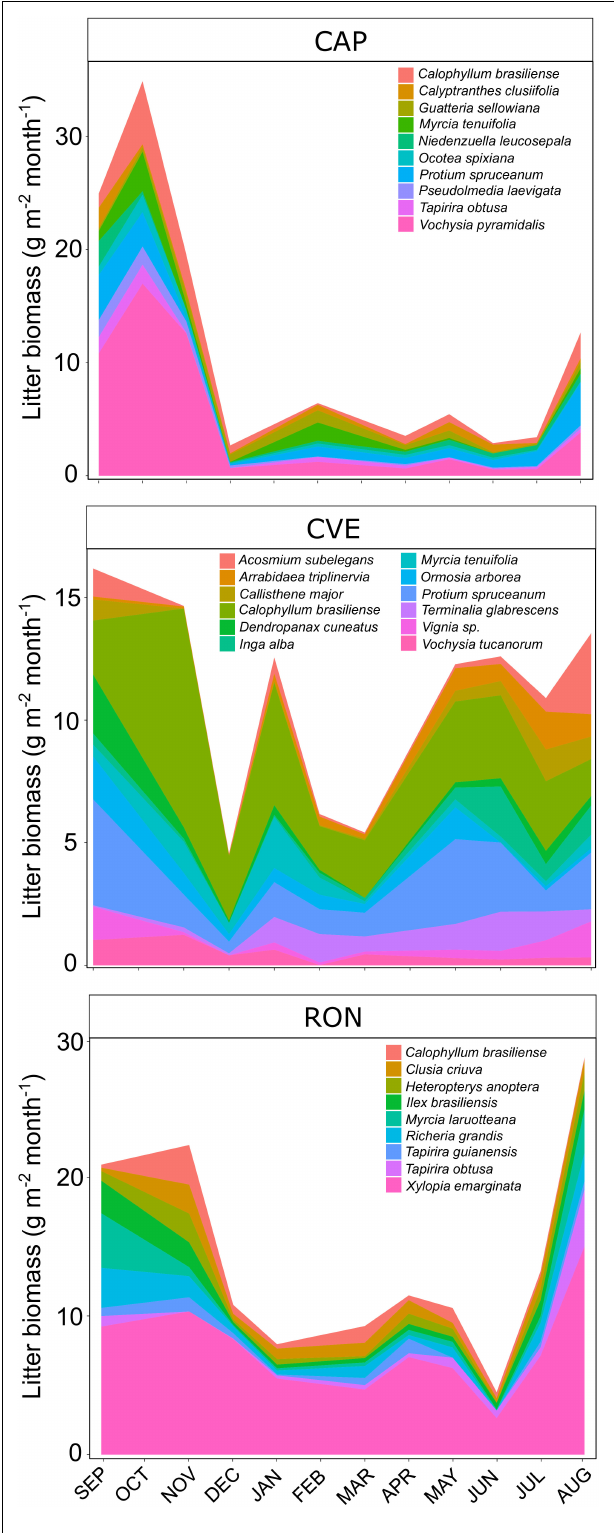
FIGURE 4 | Litter biomass of the dominant plant species (in g m - 2 month - 1 ) entering each stream (CAP, CVE, and RON) over 1 year (September 2010 to August 2011).